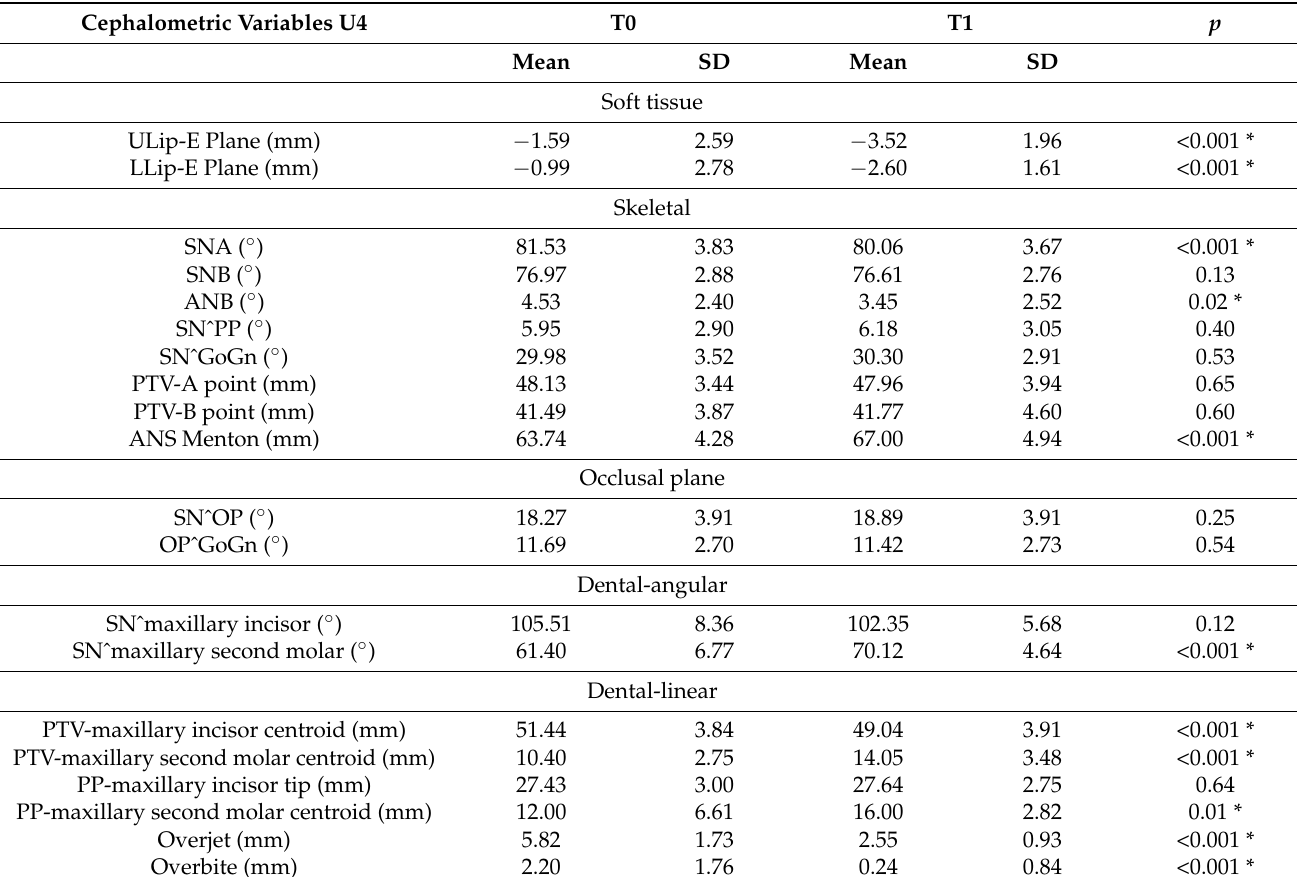
Table 2. Cephalometric variables at T0 and T1 (means and SD) for the U4 group and results of the paired sample t -test ( p -values); * p < 0.05.